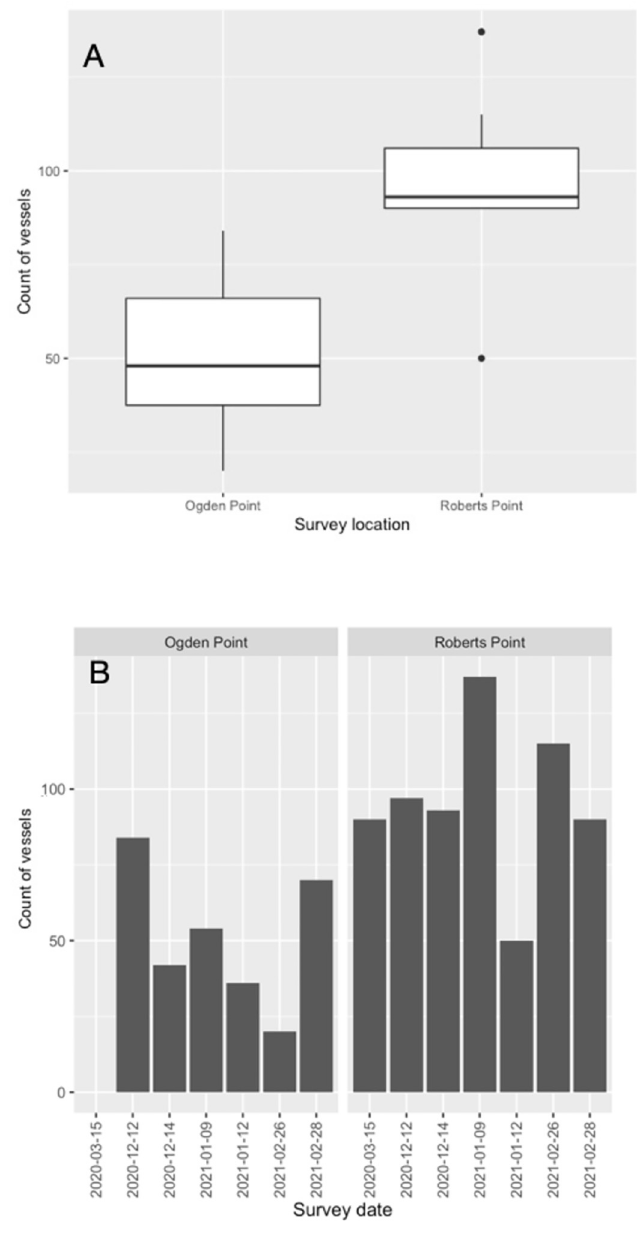
Fig 2. Boxplot summarizing daily counts of vessels (A) and raw daily count data (B) per survey site, Ogden Point (VHMBS), and Roberts Point (SHMBS), Greater Victoria,